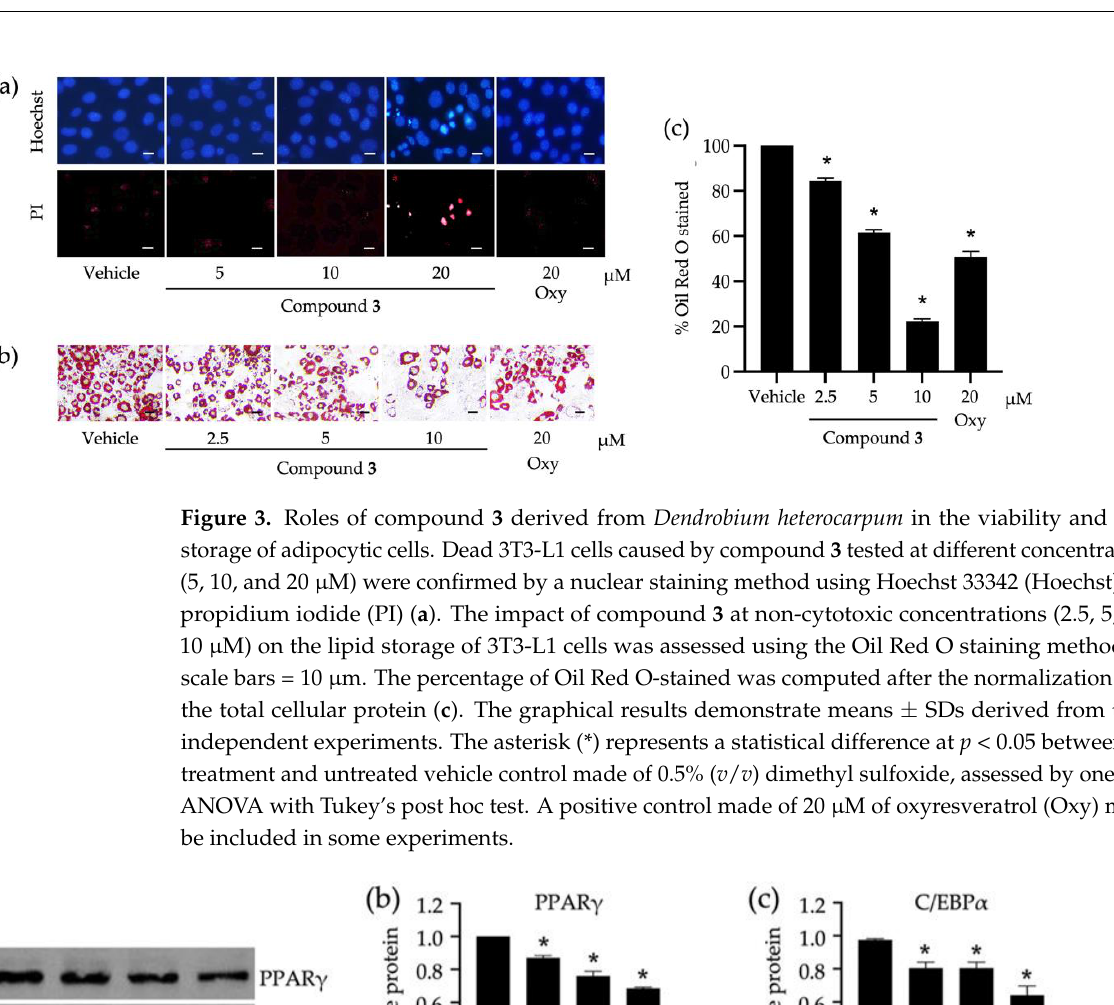
Figure 4. Impacts of compound 3 on the peroxisome proliferators activated receptor γ (PPARγ) and CCAAT/enhancer- binding protein α (C/EBPα) expression in 3T3-L1 cells. The band intensities of these transcription factors were visualized by Western blotting assay ( a ) and used for calculating their expression relative to β -Actin as a reference protein ( b , c ). Non-cytotoxic concentrations (2.5, 5, and 10 µM) of compound 3 were used in this study. The graphical results demonstrate means ± SDs derived from three independent experiments. The asterisk (*) represents a statistical difference at p < 0.05 between the treatment and untreated vehicle control made of 0.5% ( v / v ) dimethyl sulfoxide, assessed by one- way ANOVA with Tukey’s post hoc test.